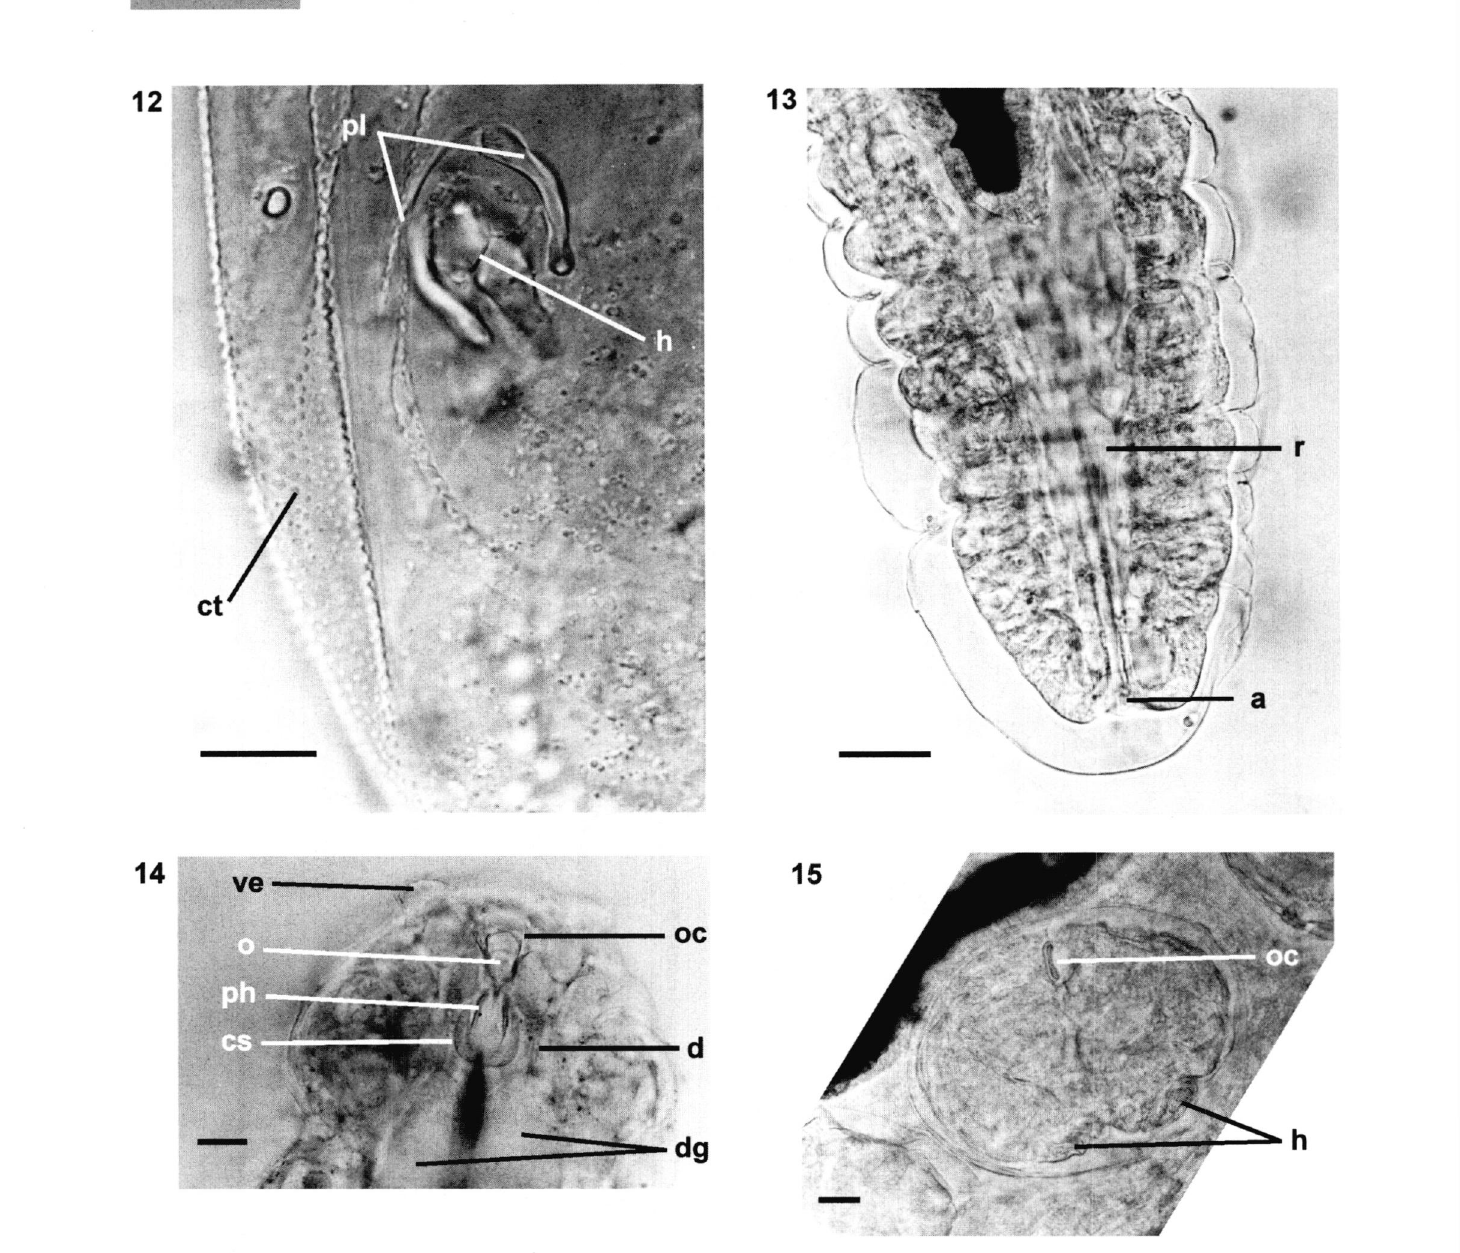
Figs 12-15. - Rileyella petauri gen. nov., sp. now 12. Cephalothorax with anterior hook (h), parapodial lobes (pl) and cuticular tubercles (ct) on body of female, lateral view, bar = 20 µm. 13- Non-bifurcate posterior extremity showing terminal anus (a) and rectum (r), ventral view, bar = 20 µm. 14. Cephalothorax illustrating ventro-lateral elevations (ve) terminating in paired, seta-like structures, oral opening (o), oral cadre (oc), pharynx (ph). unknown cresentric structure (cs) associated with posterior pharynx and mouth region, and median dorsal glands (dg) with efferent duct (d) running anteriorly, ventro-dorsal view, bar = 20 µm. 15. Egg in uterus of gravid female and containing fully developed larva with oral cadre (oc) and two pairs of hooks (h), ventral view, bar = 20